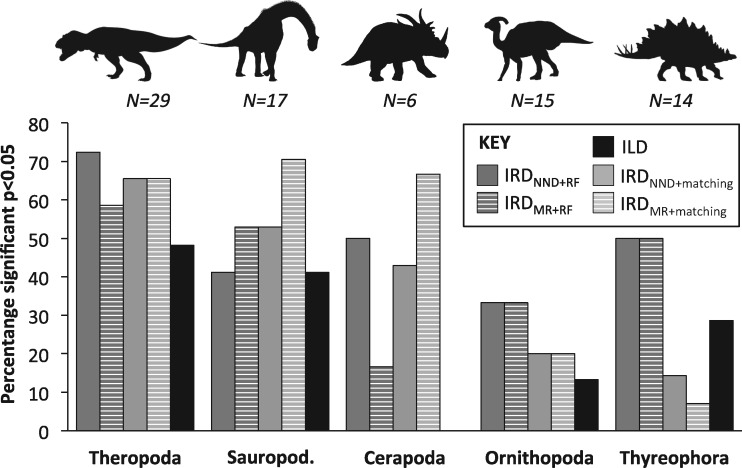
Summary of results of ILD and variants of the IRD tests, partitioned by major taxonomic group. Bars denote the percentage of data sets for which \documentclass[12pt]{minimal}
\usepackage{amsmath}
\usepackage{wasysym} 
\usepackage{amsfonts} 
\usepackage{amssymb} 
\usepackage{amsbsy}
\usepackage{upgreek}
\usepackage{mathrsfs}
\setlength{\oddsidemargin}{-69pt}
\begin{document}
}{}$P <$\end{document} 0.05. “RF” in the subscript denotes IRD tests utilizing the symmetrical-difference distance of Robinson and Foulds (1981), while “matching” in the subscript denotes tests utilizing the Matching distance of Linn et al. (2012). Comparisons are either made using majority rule consensus trees (MR), or the mean NND between each tree in one set and its nearest neighbor in the other. Silhouettes: https://publicdomainvectors.org/en/free-clipart/Tyrannosaurus-Rex-silhouette/63931.html; https://pixabay.com/vectors/silhouette-dinosaur-brachiosaurus-3464840/; https://hu.wikipedia.org/wiki/Fájl:Human-styracosaurus_size_comparison.png; https://publicdomainvectors.org/en/free-clipart/Dino-silhouette-image/63930.html; https://publicdomainvectors.org/en/free-clipart/Stegosaurus-shadow/63906.html.